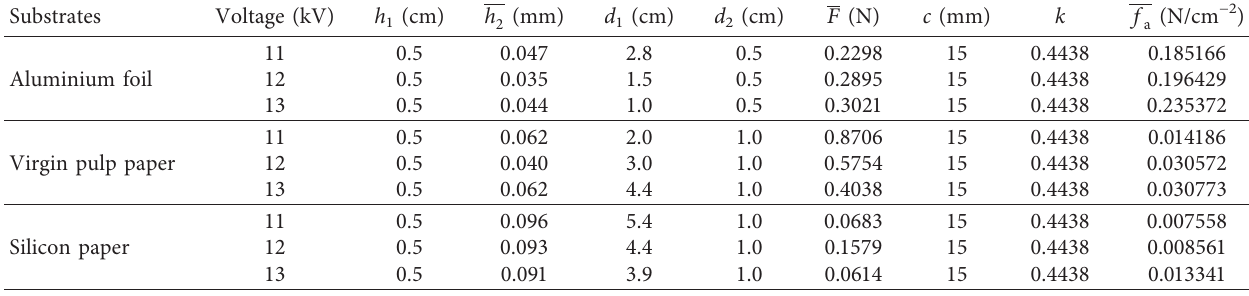
Table 1: Experimental data collected from measurement of the adhesion force f Substrates